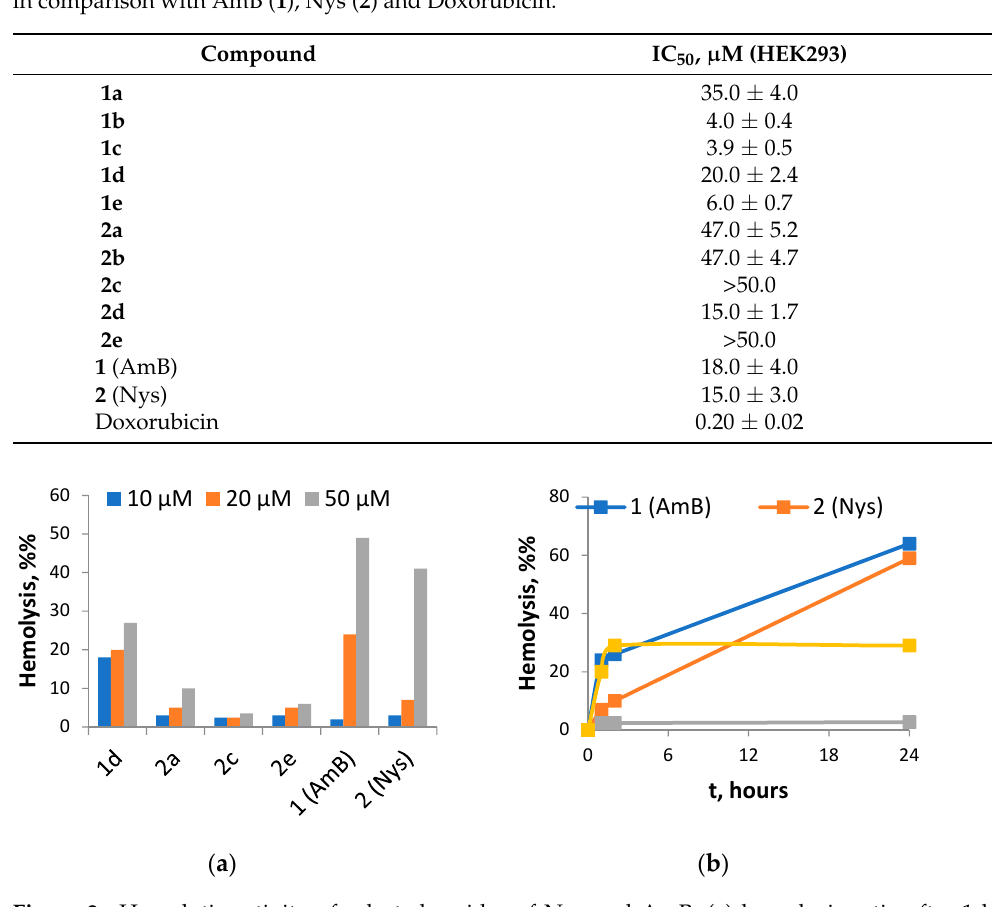
Table 2. The antiproliferative activity of the semisynthetic polyene antibiotic derivatives 1a – 1e , 2a – 2e in comparison with AmB ( 1 ), Nys ( 2 ) and Doxorubicin.